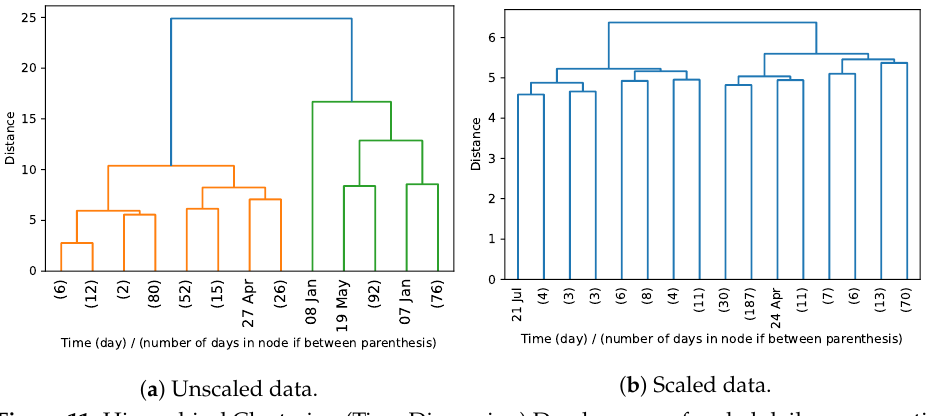
Figure 11. Hierarchical Clustering (Time Dimension) Dendrogram of scaled daily consumption at InfraQuinta,